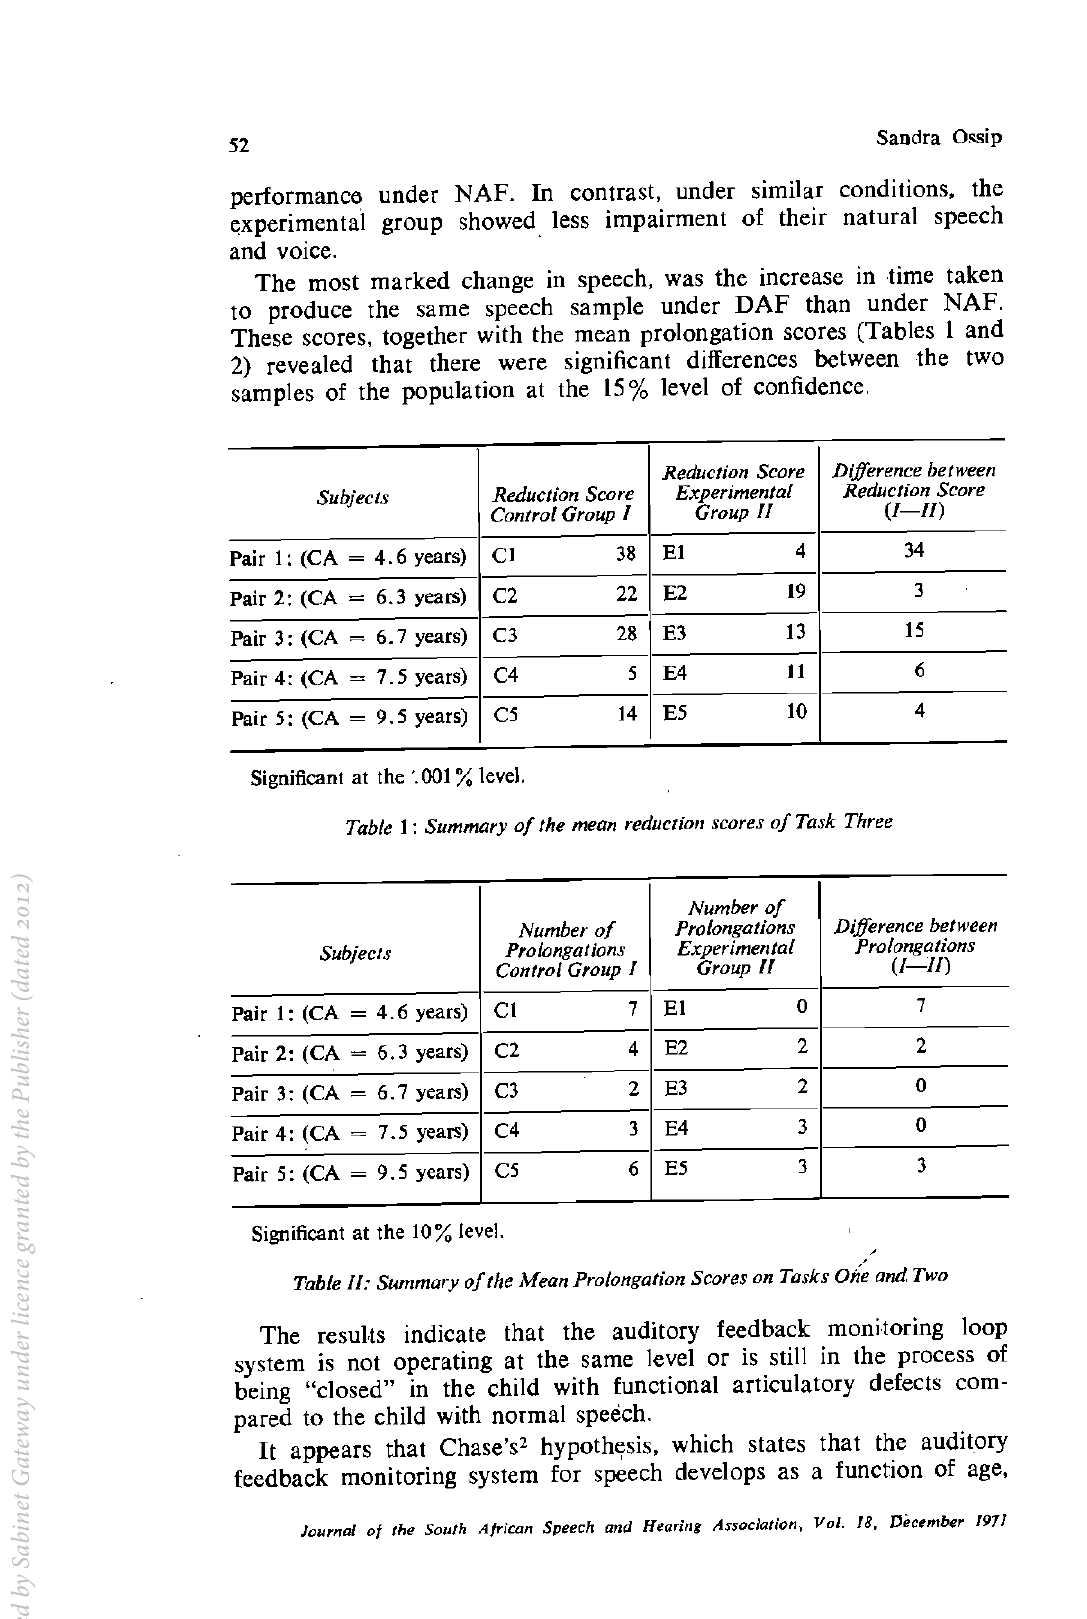
Table II: Summary of the Mean Prolongation Scores on Tasks One and Two The results indicate that the auditory feedback monitoring loop system is not operating at the same level or is still in the process